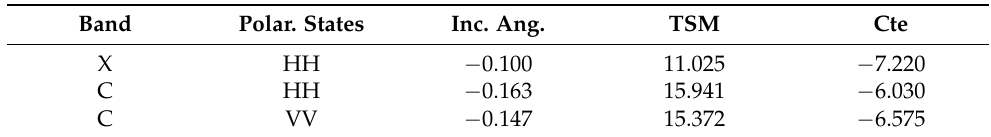
Table A1. Summary of the values of multiple linear regression parameters for relationships obtained in the X-band in the HH polarization state and in the C-band in HH and VV polarization states considering the incidence angle and the topsoil moisture. Band Polar. States Inc.